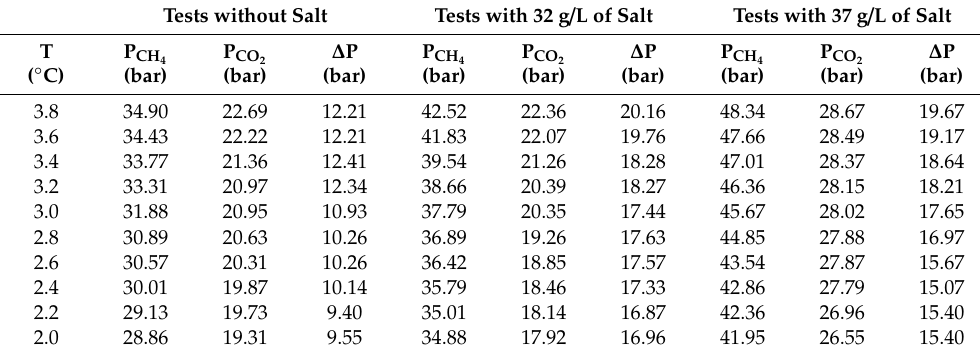
Table 11. Pressure di ff erence between CH 4 and CO 2 formation tests at di ff erent salinity concentrations. Tests without Salt Tests with 32 g / L of Salt Tests with 37 g / L of Salt